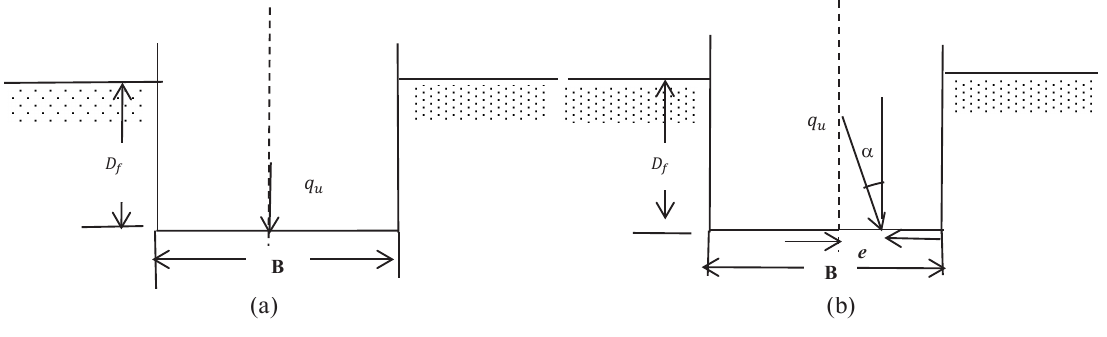
Figure 1(c): Ultimate load per unit length on a model footing: (a) axial centric load; (b) eccentric-inclined load.